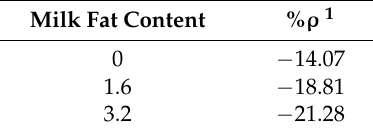
Table 3. Means % ρ values from 2 h-bioassays on 10 ppb simazine spiked UHT milk samples.